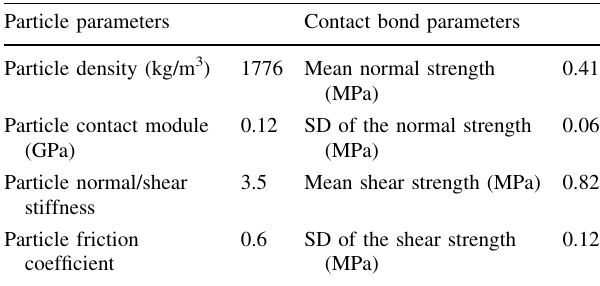
Table 2 Meso-level parameters of the soil